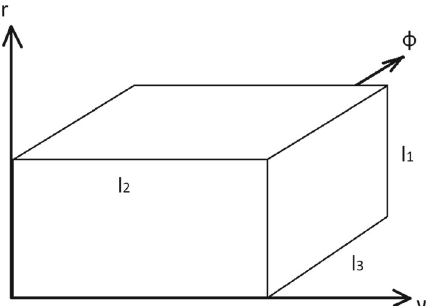
Fig. 1 The finite box of the Skyrmionic